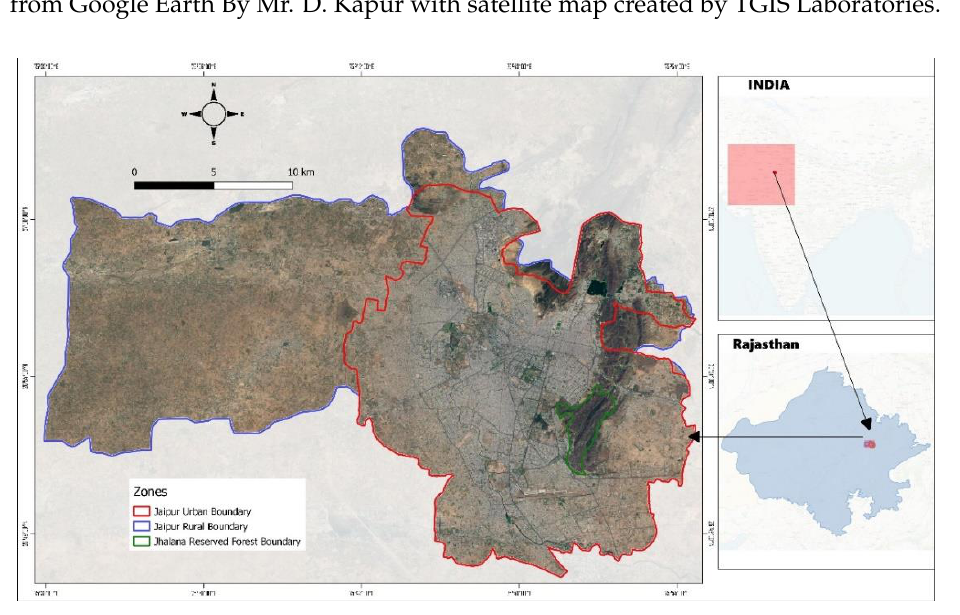
Figure 2. Satellite map of the study area showing the Urban (red), Rural (blue), and Jhalana Reserve Forest (green) zones of the conurbation of Jaipur. The IMD (Indian Meteorological Department) records the meteorological variables continuously at weather stations, including at Jaipur (Sanganer) weather station (Table 2; [23]). Map courtesy of TGIS